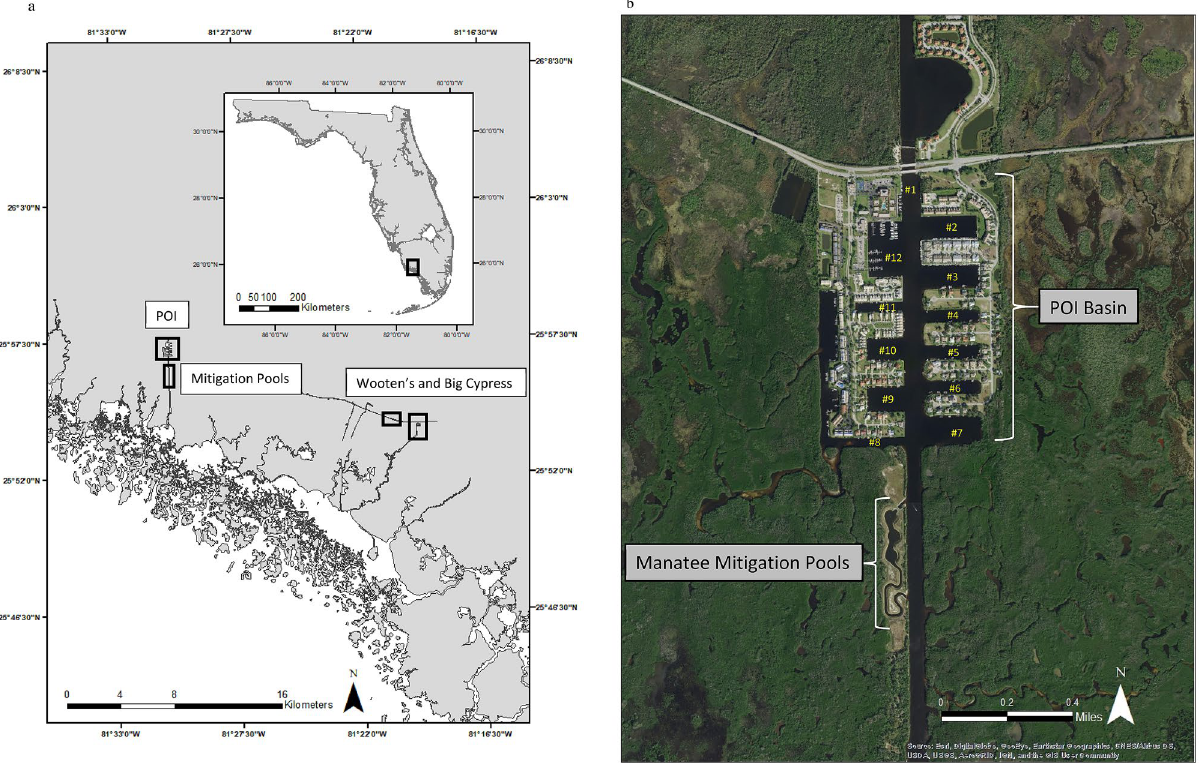
Figure 1. ( a ) Locator map of manatee aggregation sites (Port of the Islands (POI), Wooten’s Pond, Big Cypress National Preserve and the manatee mitigation pools) in the Ten Thousand Islands of south Florida, USA, ( b ) POI Basin and location of the 12 canals and mitigation pools surveyed by the UAS. Map generated in ArcMap 10.3 (https:// www. esri.